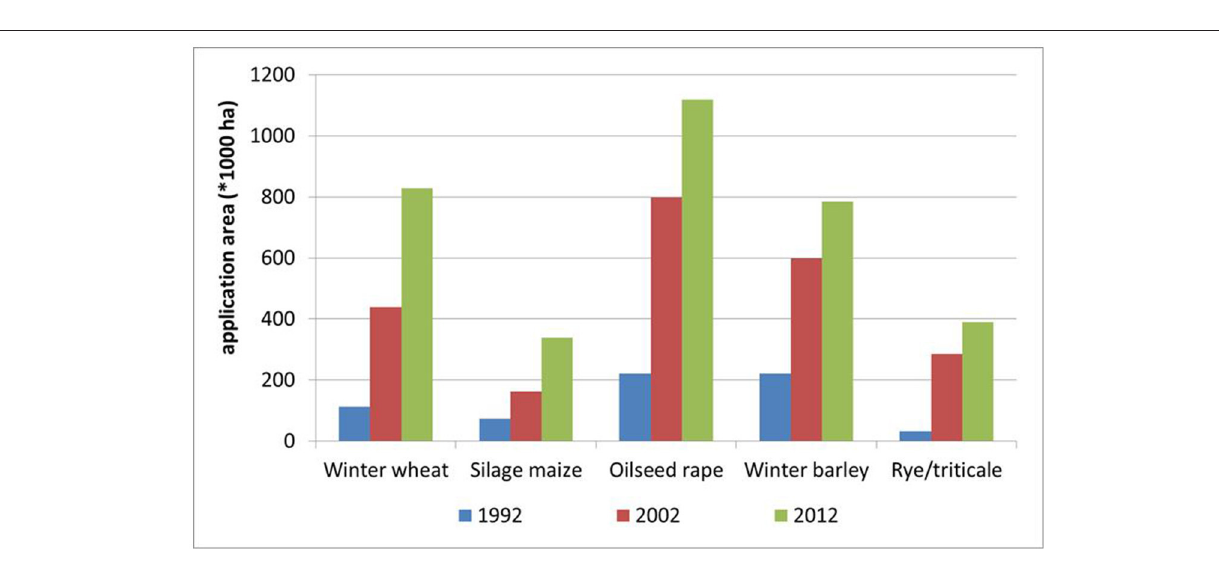
different orders. In 1992, ps/pe in mze was in rank 4, and ph